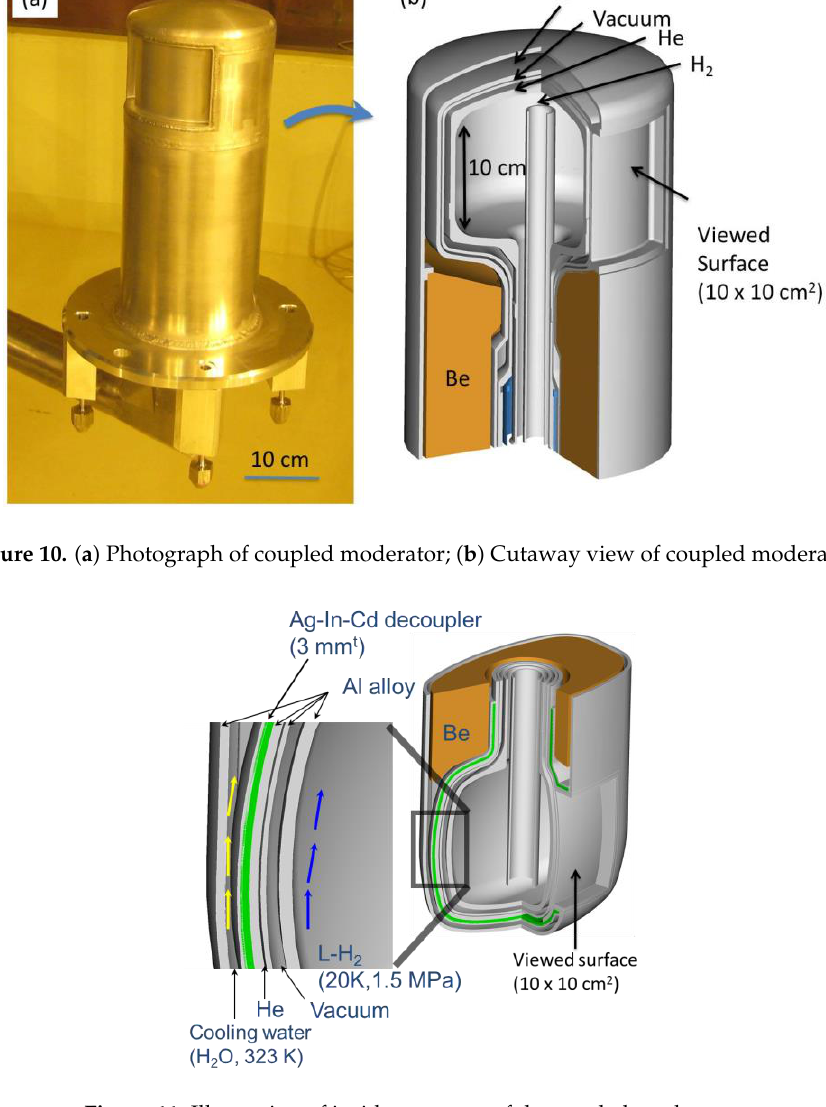
Figure 11. Illustration of inside structure of de-coupled moderator.